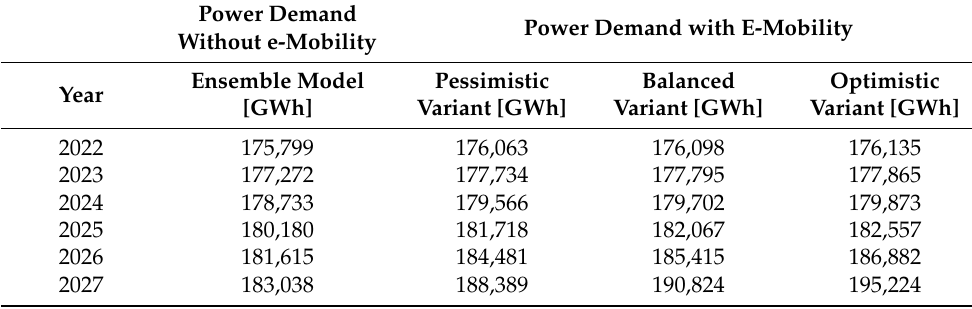
Table 5. Results of calculations of power demand with e-mobility, in three variants.